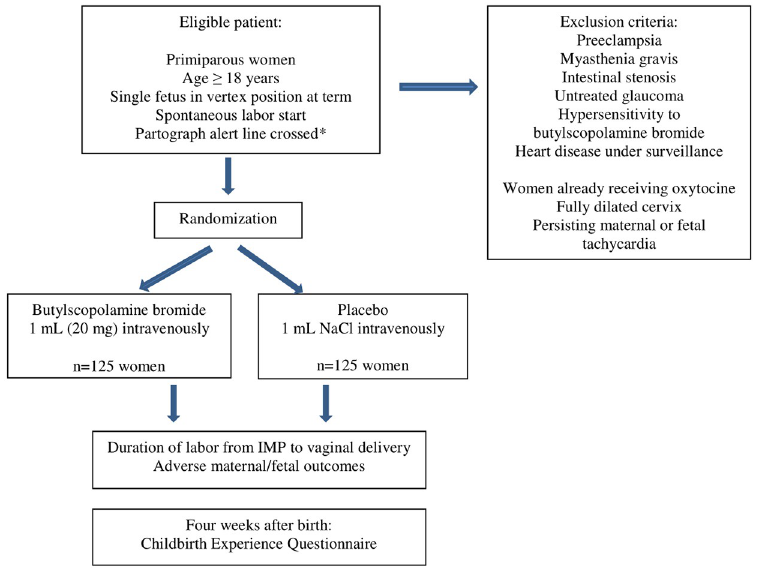
Fig 2. BUSCLAB trial design. The flow chart summarizes the design of the BUSCLAB trial. � Crossing of the alert line for slow labor progress, according to the World Health Organization partograph. If the labor curve crosses to the right of the alert line, the cervical dilation rate is < 1 cm per hour. NaCl = Sodium Chloride. IMP = Investigational Medicinal